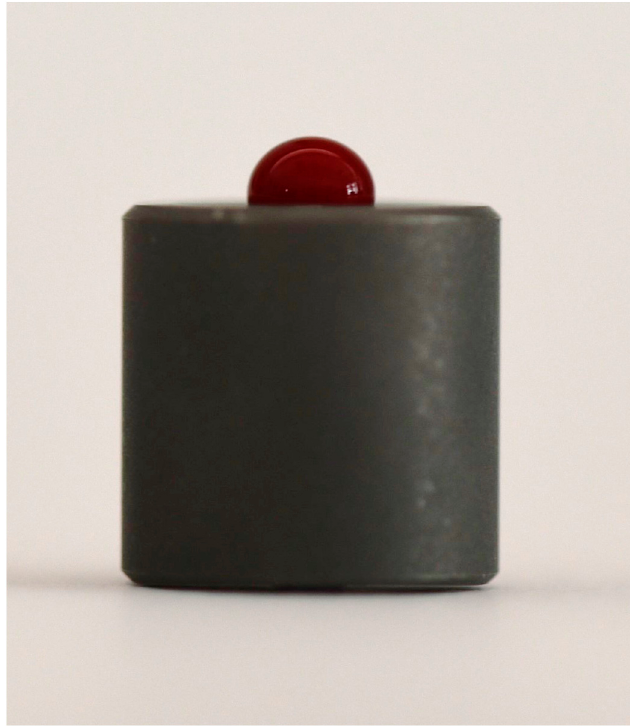
Figure 2. Following the transfer of the collected blood with a medical pipette on the titanium disc, photos were taken without modifying the settings for all